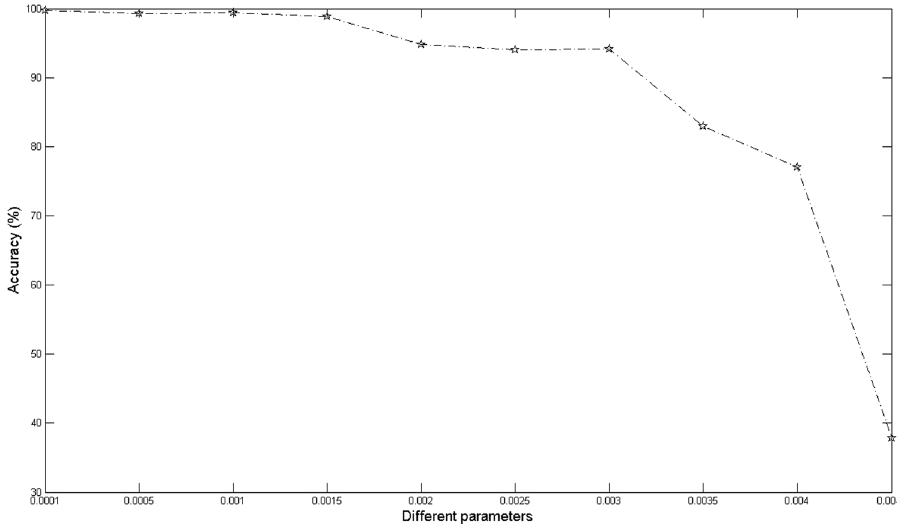
Figure 3. The identification accuracies of OMRFE with different values of l .